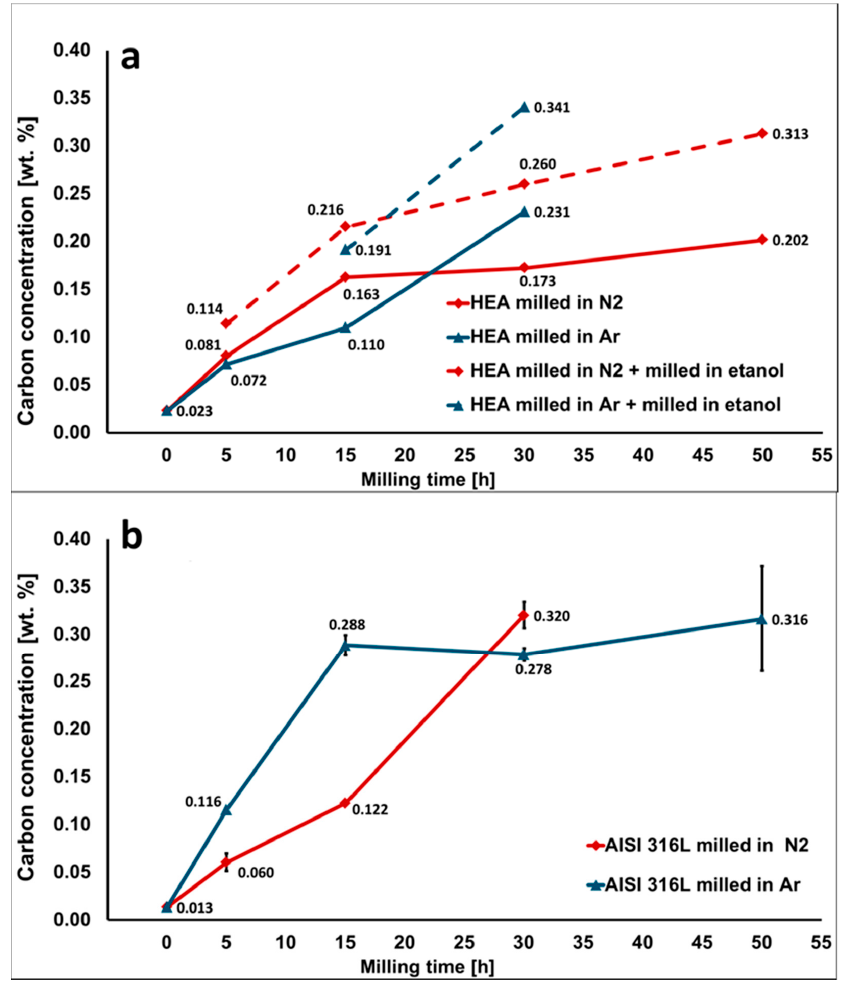
Figure 3. Carbon concentration of powders milled in Ar and N 2 atmosphere as a function of the milling time: ( a ) high-entropy alloy (HEA) powder, the dashed line represents powders additionally milled in process control agents (PCA) (ethanol) for 30 min; and ( b ) 316 L steel powder. The carbon contamination caused by the wear of high-carbon steel milling equipment is increasing with milling